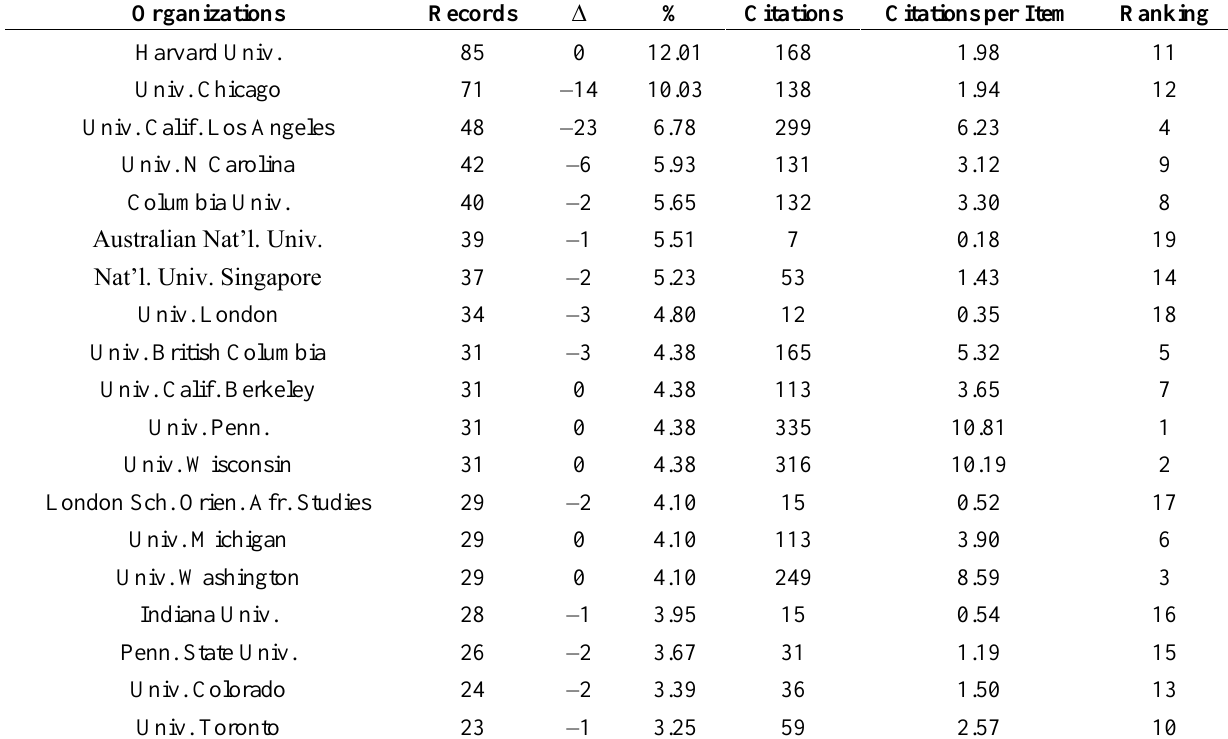
Table 10. Top 20 organizations in order of number of scholarly communications (1993–2011). Organizations Citations Citations per